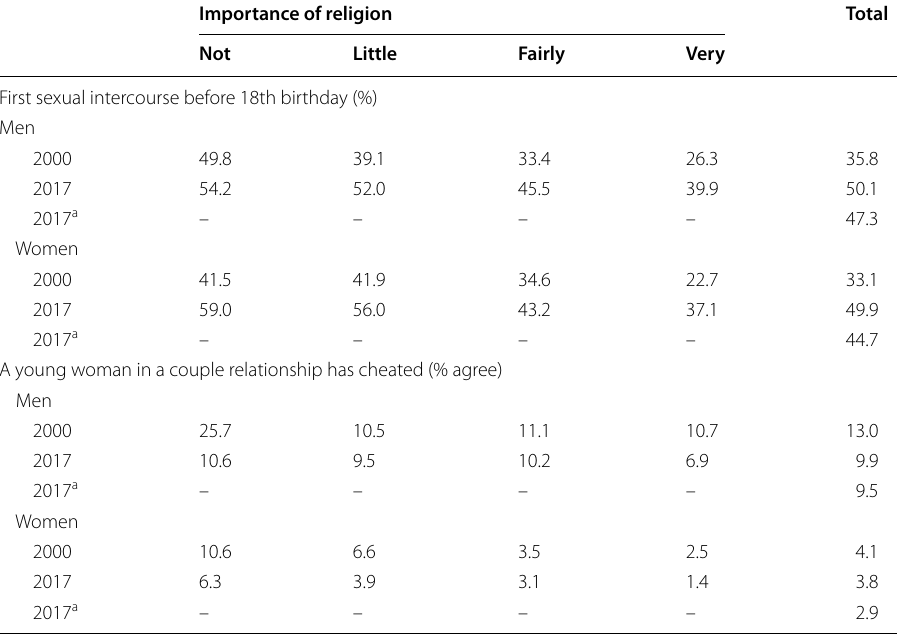
Table 5 Measuring the relationship between importance of religion on early sex and opinions on female